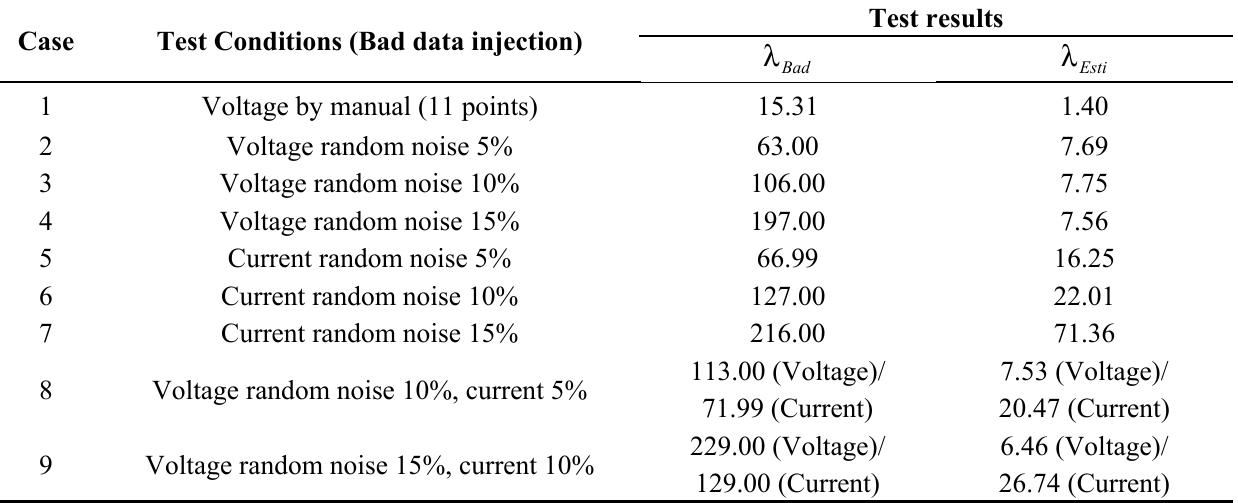
Table 7. Results of the DSE bad data